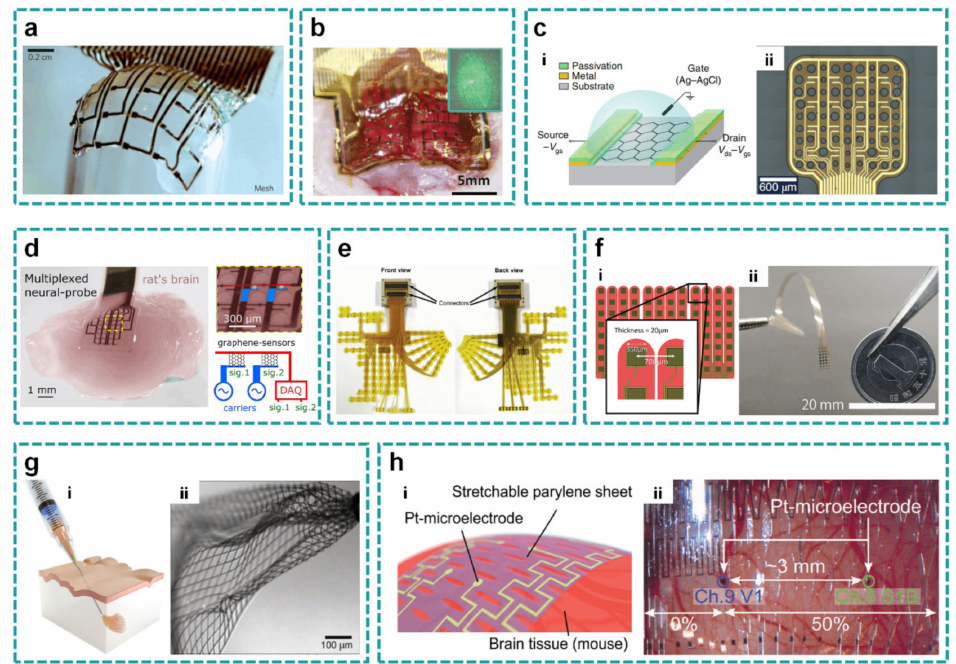
Figure 3. Open-mesh layout. ( a ) specialized square mesh designs and ultrathin forms for the polyimide-based electrodes (reprinted with permission from [74]); ( b ) clinically-friendly silk- supported bioelectrodes with ultrathin polyimide substrate structured by the square hole mesh (reprinted with permission from [90]); ( c ) flexible epicortical arrays of graphene solution-gated field- effect transistors (gSGFETs) on the polyimide substrate structured by the round hole mesh (reprinted with permission from [91]); ( d ) a multiplexed round-hole neural probe with frequency-division multi- plexing of neural signals by graphene sensors (reprinted with permission from [92]); ( e ) a finger-like ECoG array to record neural activity simultaneously from different regions (reprinted with permis- sion from [93]); ( f ) a finger-like 96-channel ECoG array with high temporal and spatial resolution (reprinted with permission from [94]); ( g ) the syringe injection of submicrometer-thick, centimeter- scale macroporous 3D mesh electrodes through needles (reprinted with permission from [73]); ( h ) A Pt microelectrode array embedded in 11 µ m thick krigami parylene film (reprinted with permission from